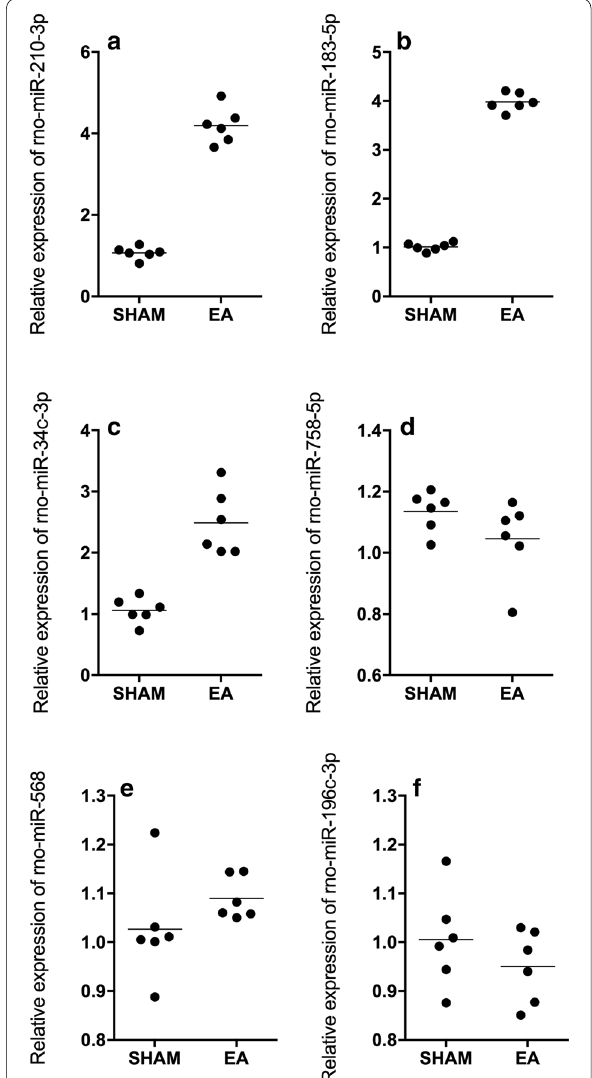
Fig. 1 Rno-miR-183-5p, rno-miR-34c-3p and rno-miR-210-3p expression was enhanced in rats treated with EA (Real-time PCR; Technical repeats n 3; Animal number in each group N 6; *p = = value < 0.05, vs SHAM group). a Expression of rno-miR-183-5p was increased in EA-treated rats compared with sham-operated rats. b Expression of rno-miR-34c-3p was increased in EA-treated rats compared with sham-operated rats. c Expression of rno-miR-210-3p was increased in EA-treated rats compared with sham-operated rats. d Rno-miR-758-5p expression remained unchanged in sham rat group and EA rat group. e Rno-miR-568 expression remained unchanged in sham rat group and EA rat group. f Rno-miR-196c-3p expression remained unchanged in sham rat group and EA rat